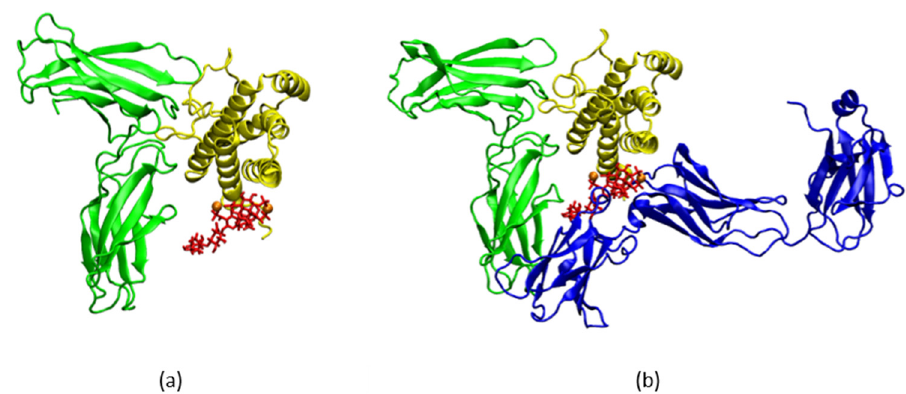
Figure 8. The IL-6/IL-6R α /LMWH/2Mg 2+ complex. ( a ) IL-6 in yellow, heparin in red, IL-6R α in green; Mg 2+ ions presented as orange spheres; ( b ) The same complex, with gp130 receptor (in blue) super- imposed.